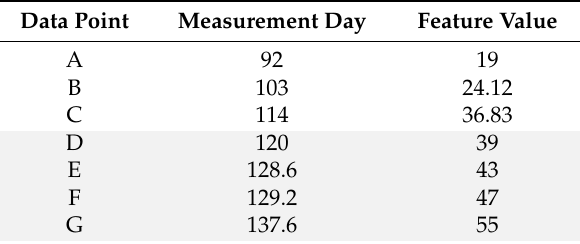
Table 10. Original non-linear data points and predicted data points of WD kurtosis.